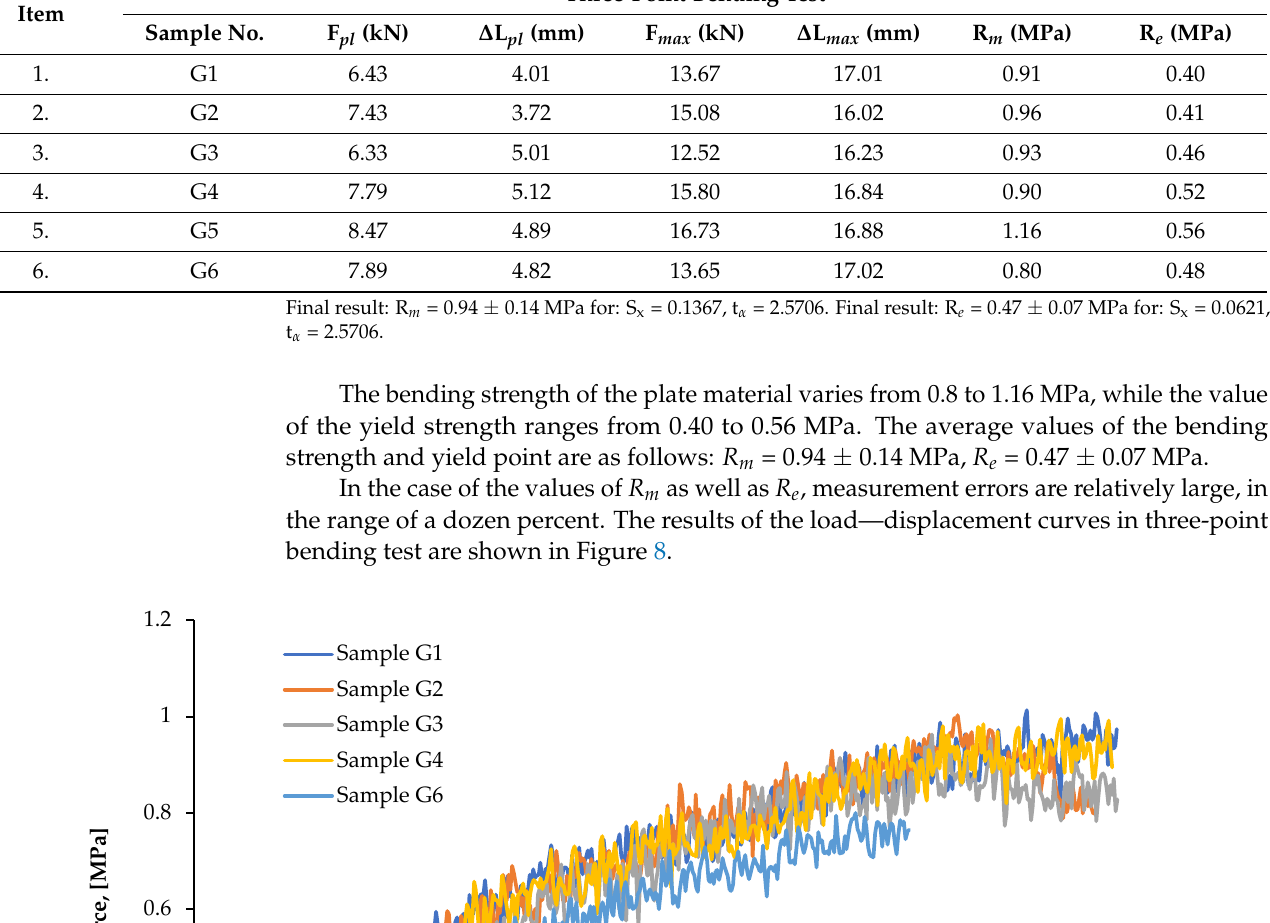
Table 3. Results of calculations of the bending strength and the yield point of plates.